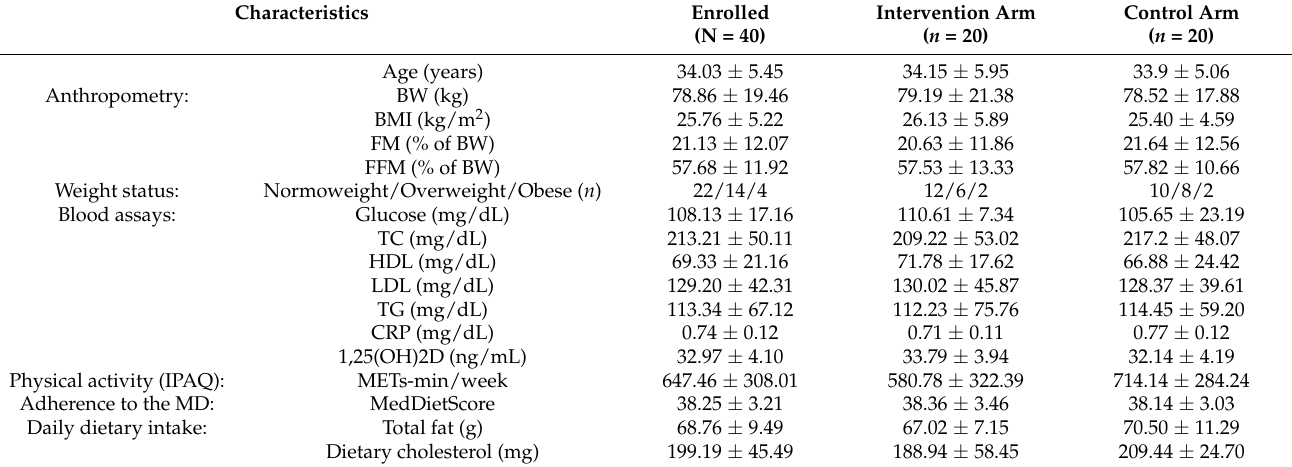
Table 2. Characteristics of the participating women at baseline *.